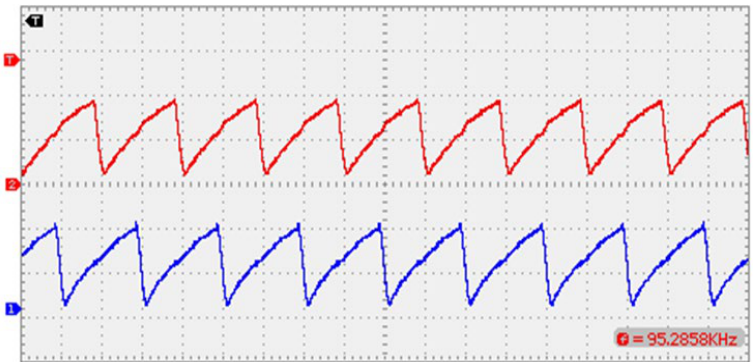
Figure 15. Inductor currents I L8 ( top ) and I L7 ( bottom ) (vertical scale 5 A/div).